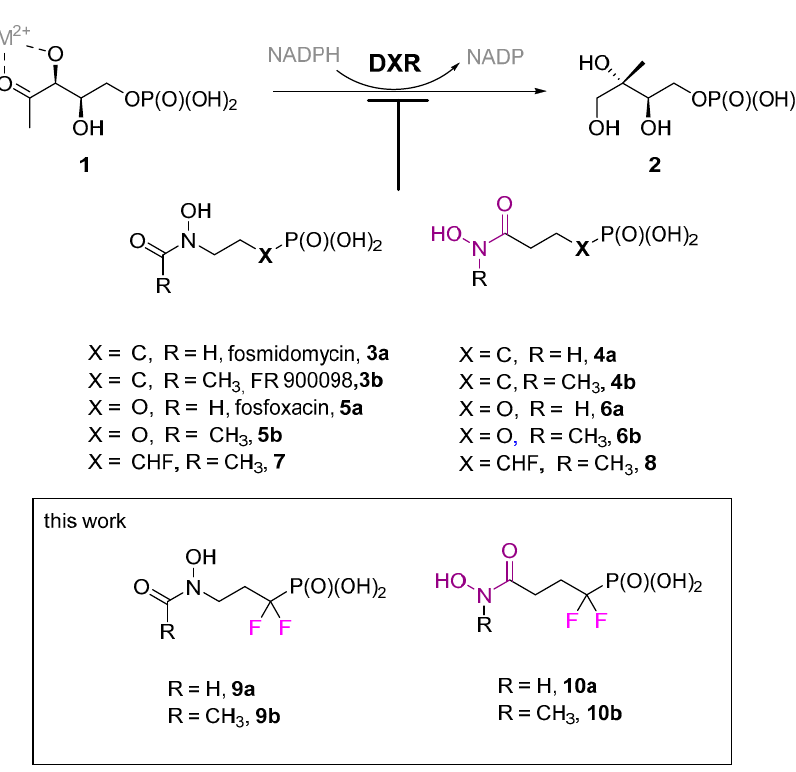
Scheme 1. The 1-deoxyxylulose 5-phosphate reductoisomerase (DXR) and its